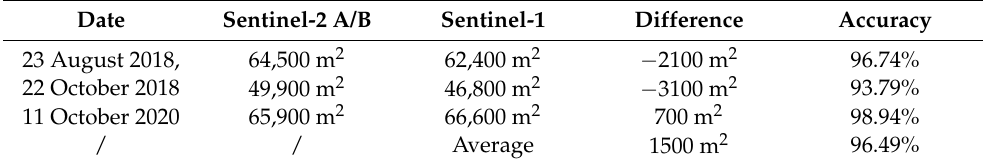
Table 2. Comparison of the area of the XGL extracted from Sentinel-2 A/B optical images with that extracted from Sentinel-1 SAR image acquired on the same